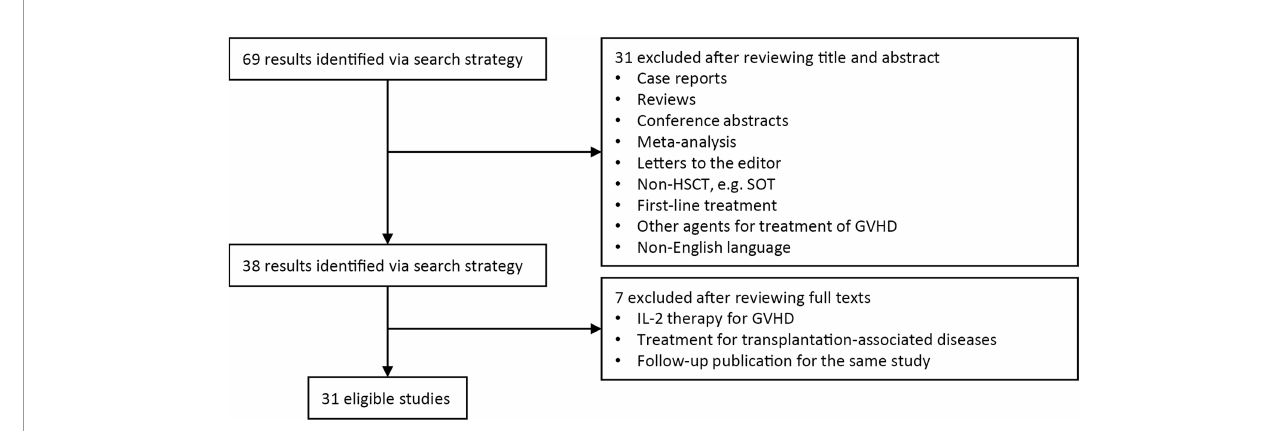
FIGURE 1 | Selection scheme of studies. GVHD, graft-versus-host disease; HSCT, hematopoietic stem cell transplant; SOT, solid